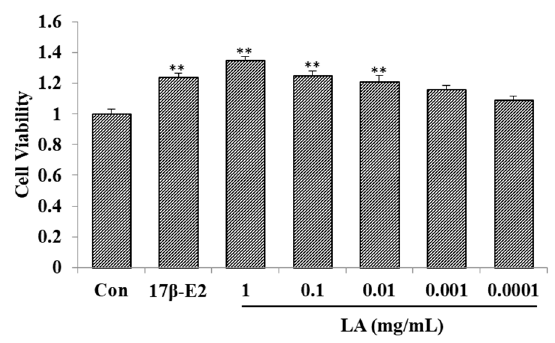
Figure 1. Effect of Lepidium apetalum Willd (LA) on MCF-7 cell proliferation ( x ± SD, n = 3). * p < 0.05; ** p < 0.01 compared to controls.